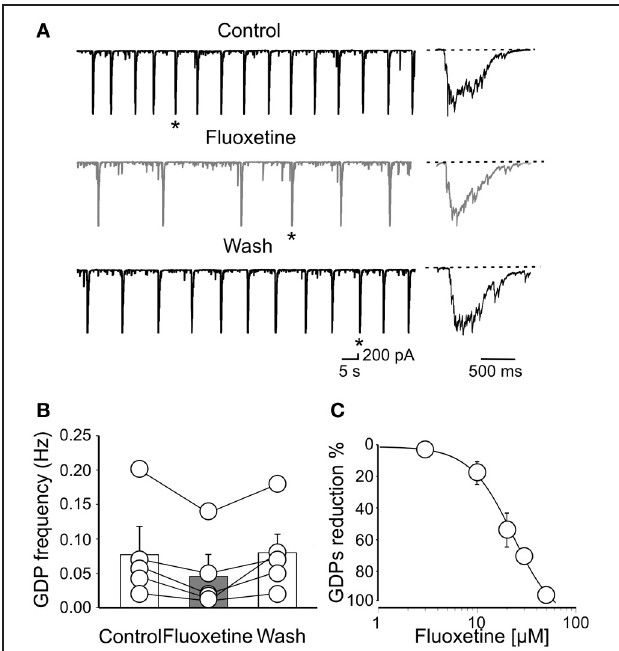
FIGURE 1 | Fluoxetine reduces the frequency of Giant Depolarizing potentials. (A) GDPs recorded before, during and after (Wash) application of fluoxetine (20 μ M). GDPs marked with an asterisk are shown on the right on an expanded time scale. (B) Population graph of GDPs frequency before, during and after application of fluoxetine. Columns represent the mean ± SEM. (C) Fluoxetine depressed GDPs in a concentration-dependent way. Each point represents the mean value of five individual experiments. Bars are the SEM (they are often within the symbols). Data points were fitted with the Hill equation (the IC 50 value was 22 μ